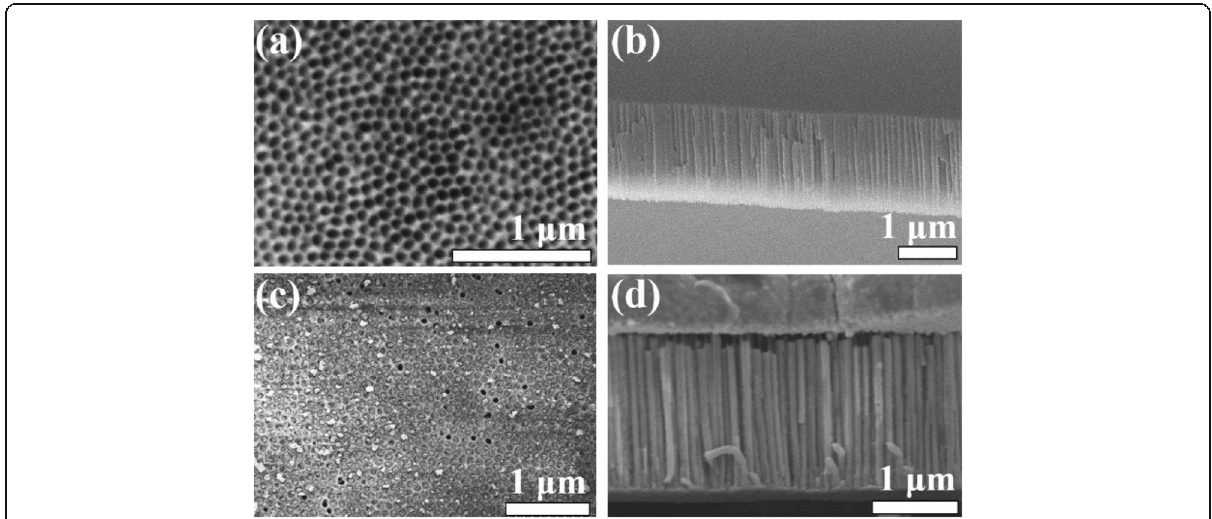
Fig. 2 a Top view and b cross-section SEM images of AAO before electrodeposition. c Top view and d cross-section view SEM images of AAO after CuO electrodeposition (scale bar, 1 μ m)